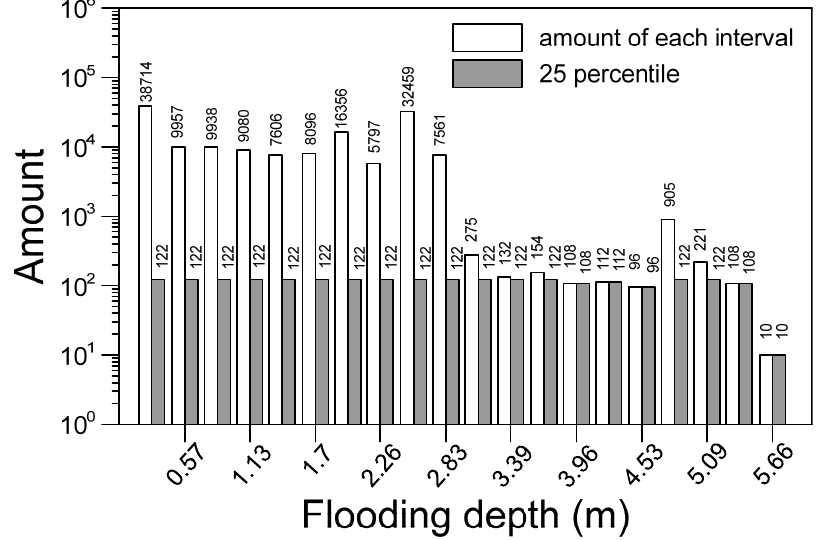
Figure 3. Original amount of data in various flooding depth ranges and the amount of 25th percentile